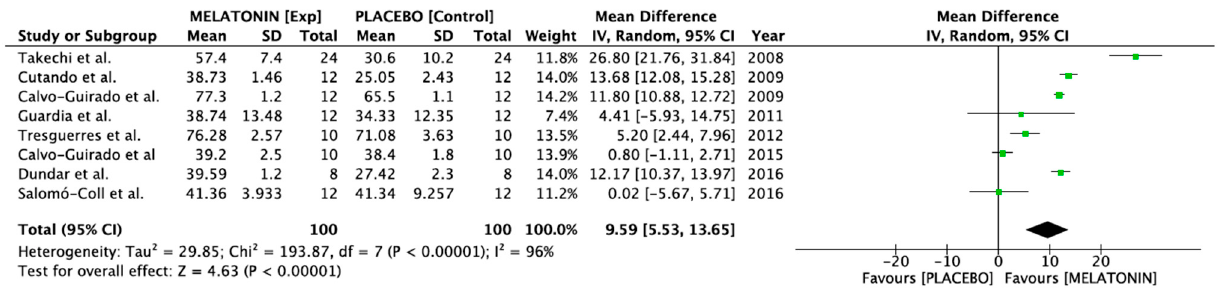
Figure 3. Forest plot for the meta-analysis of animal studies assessing bone-implant contact between 2 to 6 weeks after placement, taking the mean difference as the effect size index, weighting by inverse variance and assuming a random effects model. CI = Confidence Interval.